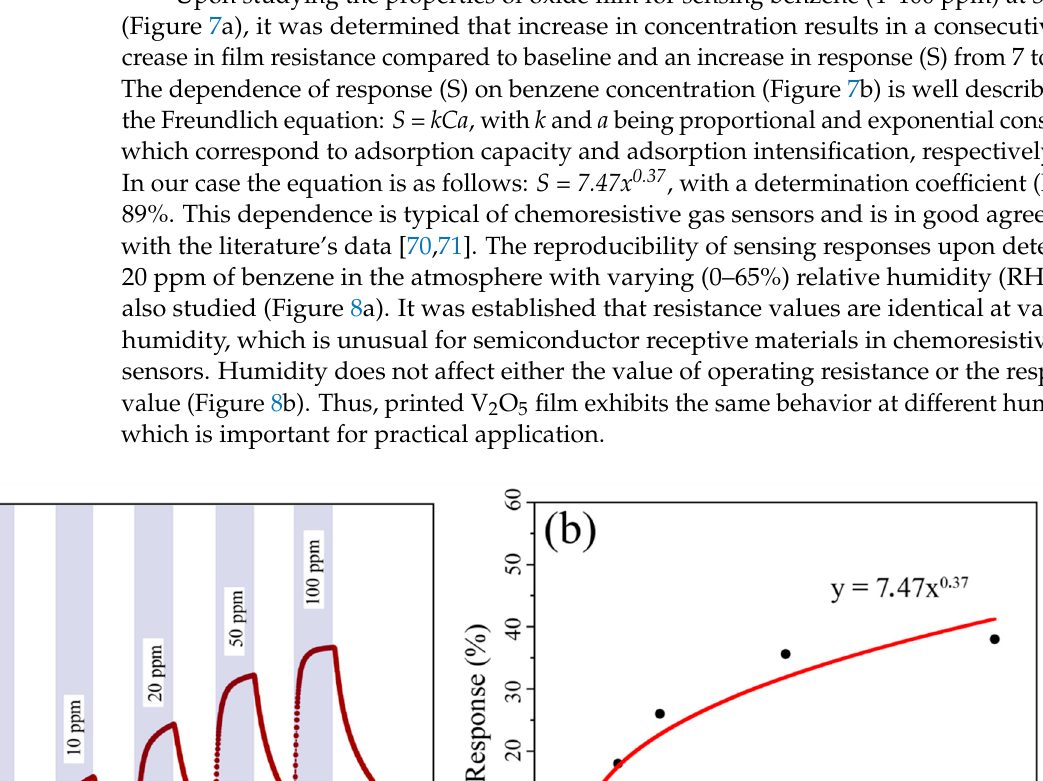
Figure 8. Experimental curves of resistance change upon sensing 20 ppm of benzene at varying relative humidity ( a ); Dependence of sensing response to 20 ppm of benzene from relative humidity ( b ); Selectivity diagram: sensing responses to various analyte gases at 300 °C ( c ).